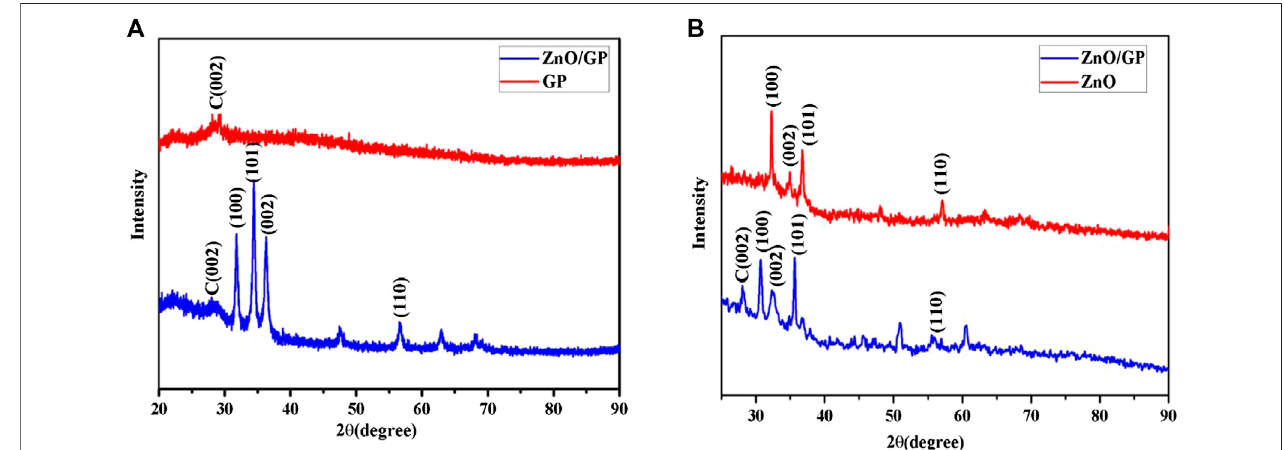
FIGURE 3 | XRD spectra of graphene and graphene/ZnO nanorods (A) . ZnO and graphene/ZnO nanorods (B)